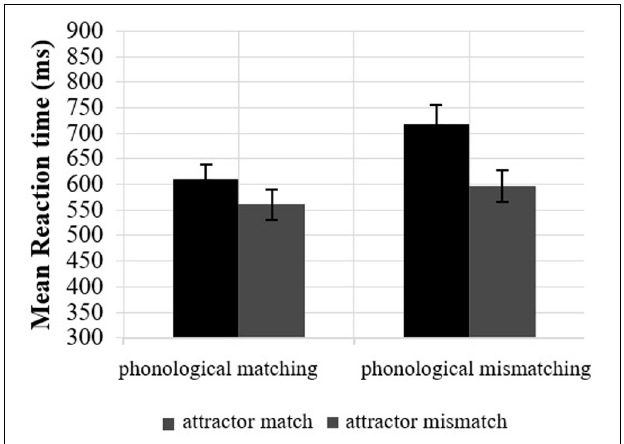
FIGURE 2 | Mean reaction times in ungrammatical sentences by Attractor (match, mismatch) and Phonological matching (phonological matching/mismatching) in feminine heads on Region 5 (Agreement target) in Experiment 1. Error bars indicate the standard error of the mean across